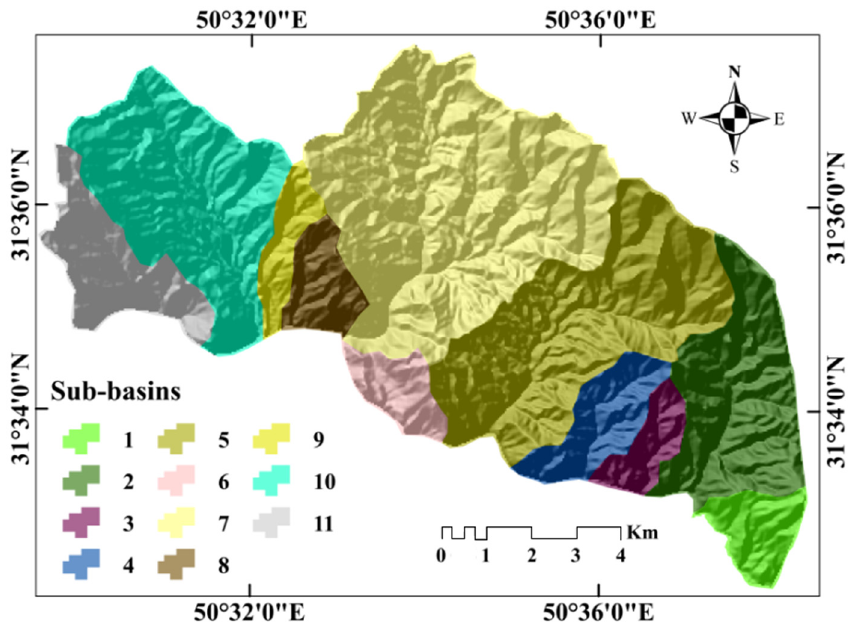
Figure 5. Sub-basins of the Kalv¯ar¯ı Figure 5. Sub ‐ basins of the Kalv ā r ī basin.